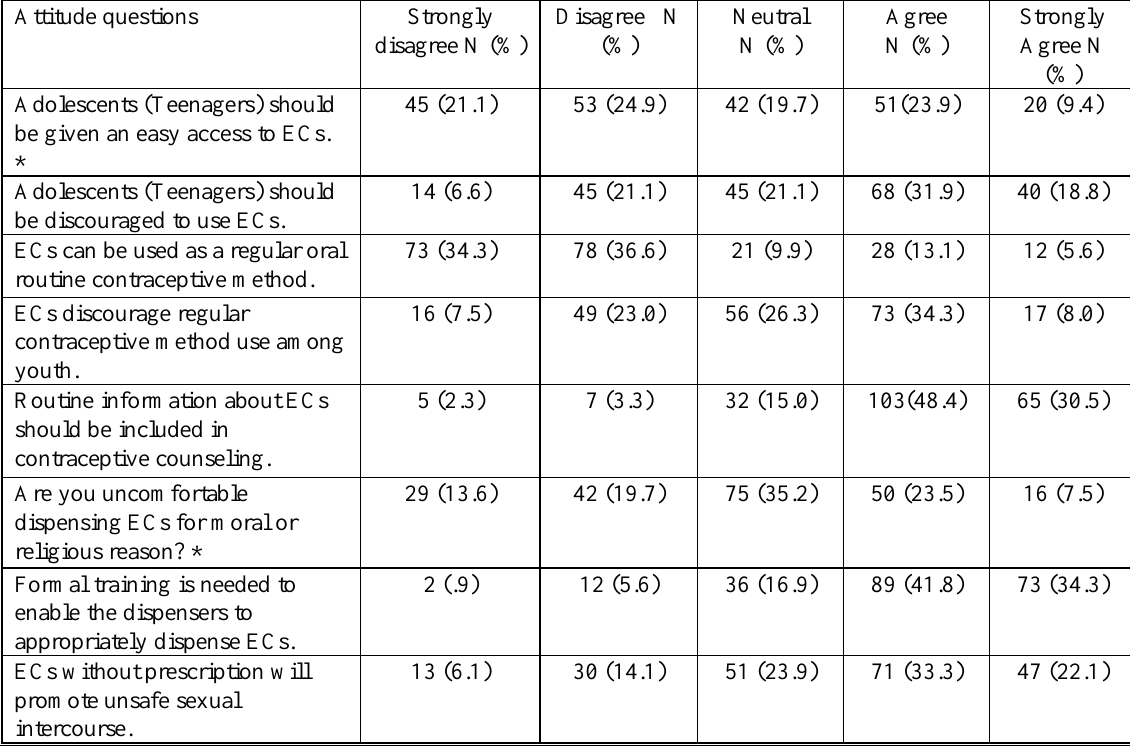
Table 4. Attitude of community pharmacists towards emergency contraceptives.